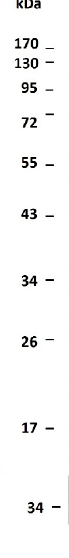
Figure 1. Induction of recombinant Trx-rHelja expression. The protein profile of extracts was obtained after lysis of cells from un-induced ( − ) or isopropyl β - D -1-thiogalactopyranoside (IPTG) induced (+) E. coli cultures. The extracts obtained from 0.1 mL of cell cultures with an OD at 600 nm of 1.5 were loaded on a 12% denaturing polyacrylamide gel electrophoresis, SDS-PAGE, and subsequently stained with Coomassie Brillant Blue ( A ). Immunodetection of Trx-rHelja in extracts of 0.01 mL of un-induced ( − ) or IPTG induced (+) cell cultures. Gel performed as described above was transferred to nitrocellulose, blocked and incubated sequentially with 1:3000 anti-Helja polyclonal antibodies and alkaline phosphatase-conjugated anti-rabbit IgG 1:10,000 ( B ). Figures are representative of three ( n = 3) independent experiments. Molecular mass markers are indicated on the left.